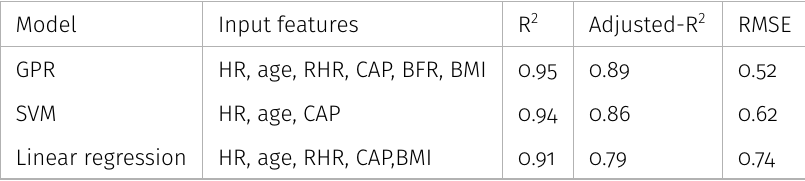
Table IV. Performance comparison of different models.